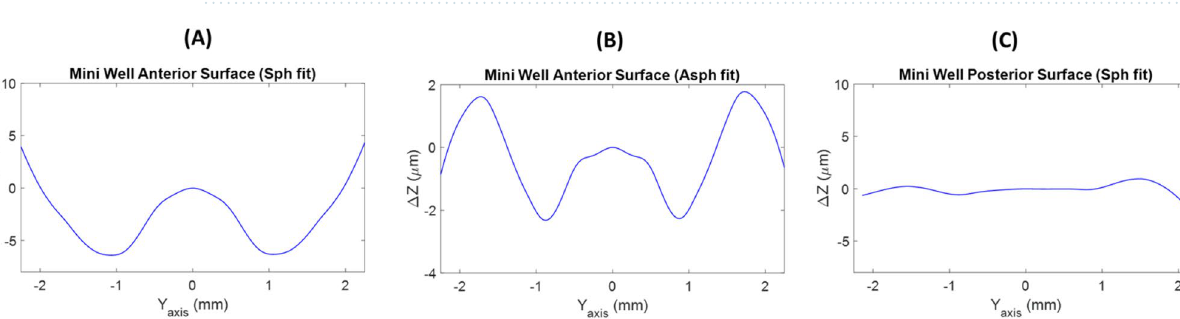
Figure 6. Subtraction lines obtained after the removal of the best-fit sphere ( A ) or asphere ( B ) of the anterior surface and best-fit sphere ( C ) of posterior surface from the smooth profiles of the Mini Well Ready